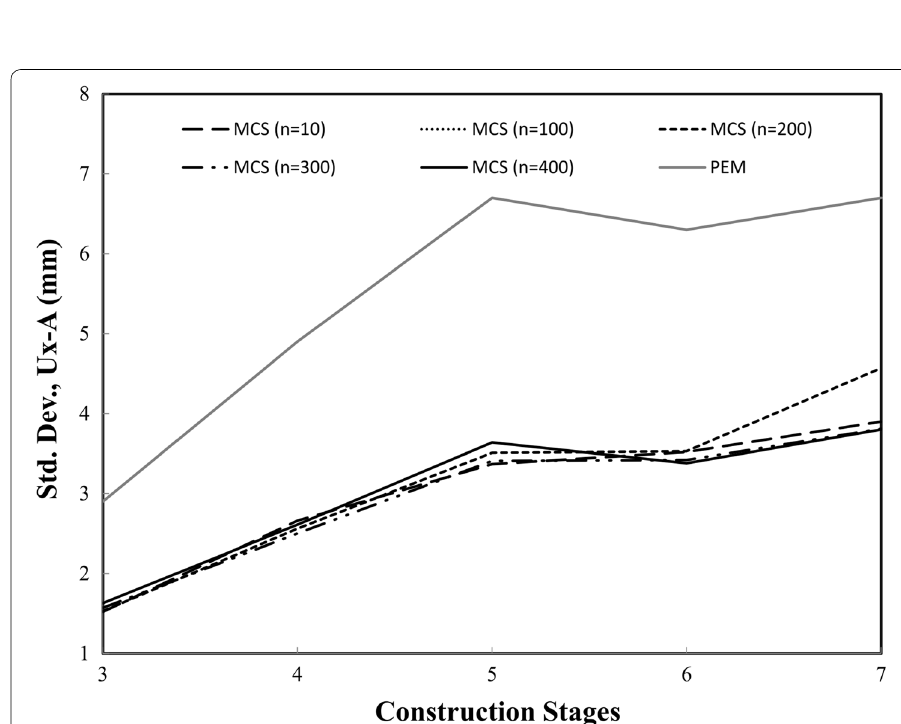
Fig. 9 Standard deviation values of U x